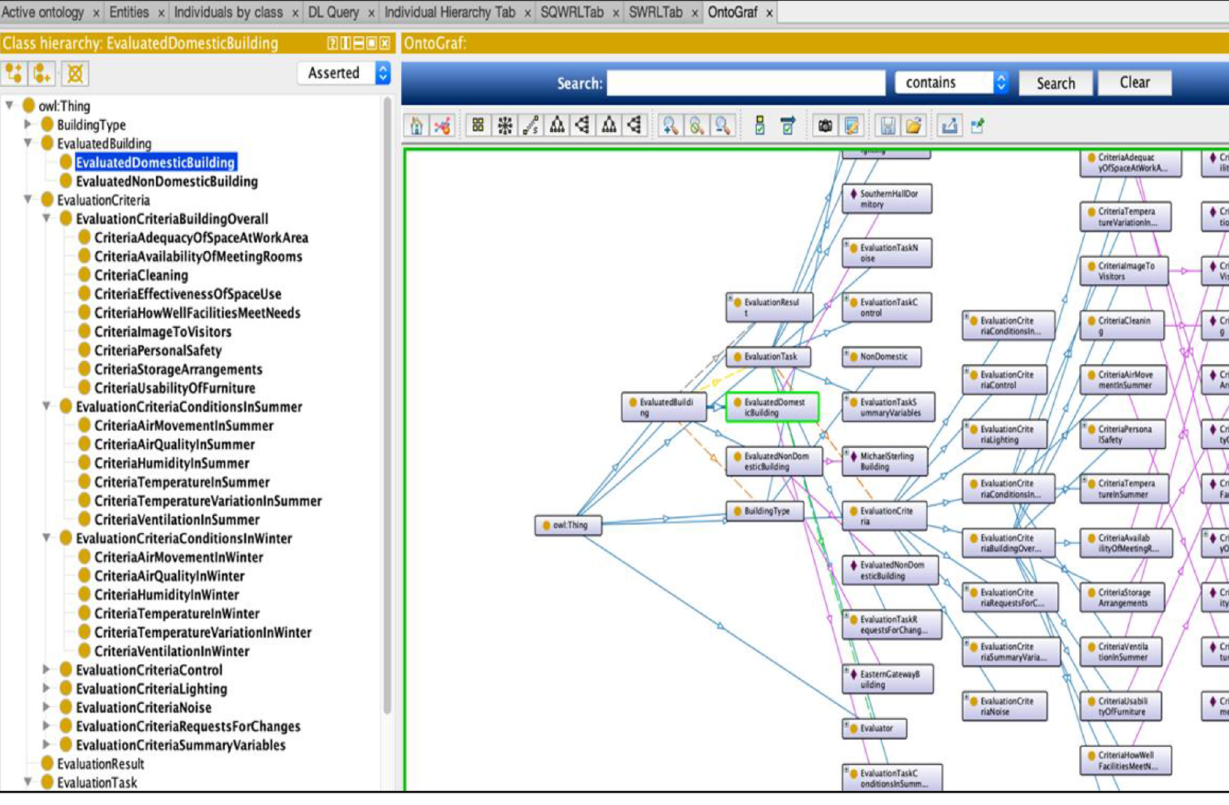
Fig. 3. The proposed ontology model.